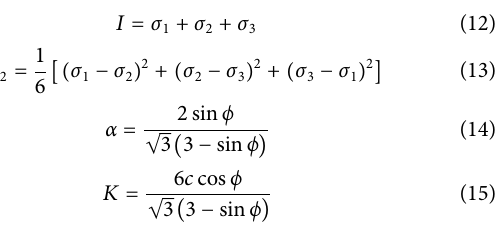
Frontiers in Earth